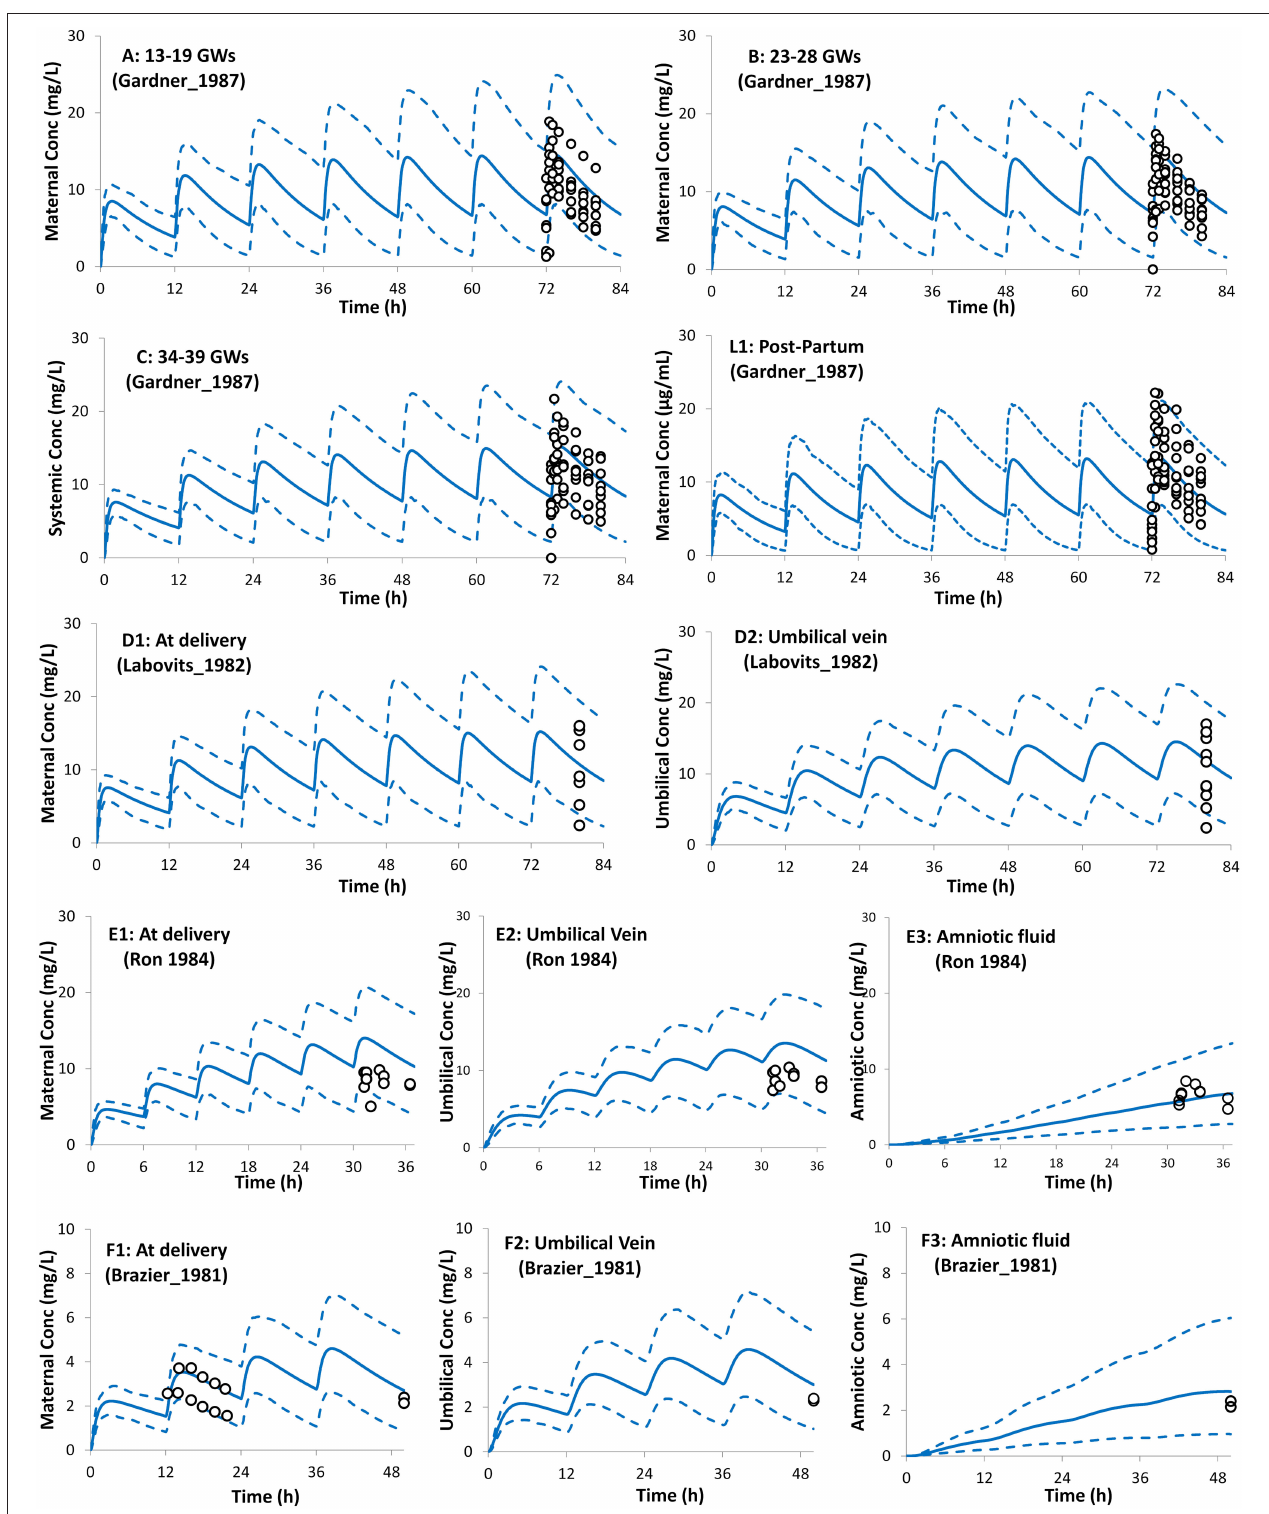
FIGURE 3 | Plasma concentration profiles after multiple oral administration in pregnant population during pregnancy and at delivery. Solid lines, predicted means; Dashed lines, 5th and 95th centiles; Circles, individual observations (open, maternal; filled, umbilical cord). Plots representing the following trials: (A) Trial design P1 (45), (B) Trial design P2 (45), (C) Trial design P3 (45), (L1) Trial design L1 (45) added here for comparison (see lactation section), (D1,D2) Trial design P4 (46), (E1–E3) Trial design P5 (47), and (F1–F3) Trial design P6 (48). See the Method section for trial settings.